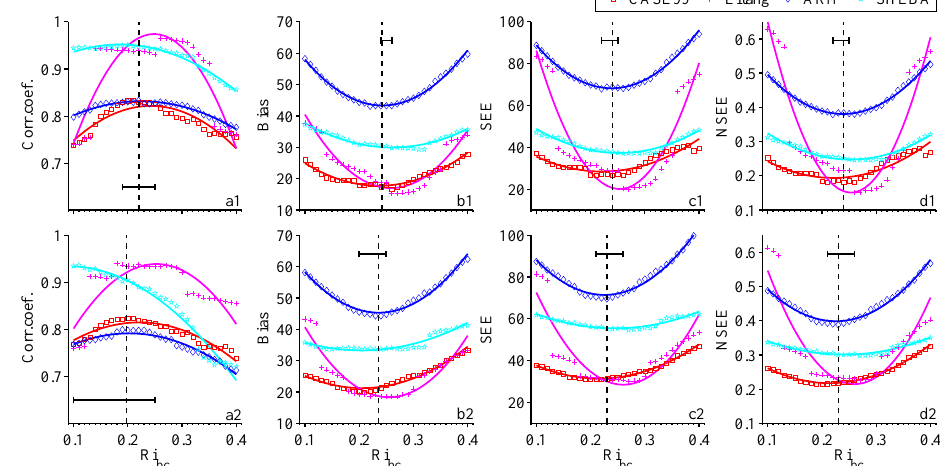
Figure 8. Comparison between estimated PBLH using the bulk Richardson number method with z s = 40m (upper panels) and z s = 80m (lower panels) and observed PBLHs for type I SBLs. The correlation coefficient (a) , bias (b) , standard error (c) , and normalized standard error (d) are shown. The sounding data are taken from Litang (plus sign), CASES99 (square), ARM Shouxian (diamond), and SHEBA (pentacle). The curved lines are obtained by quadratic curve-fitting, the black vertical dashed lines indicate a representative Ri bc for all four sites, and the error bars indicate the range of Ri bc across the four sites.